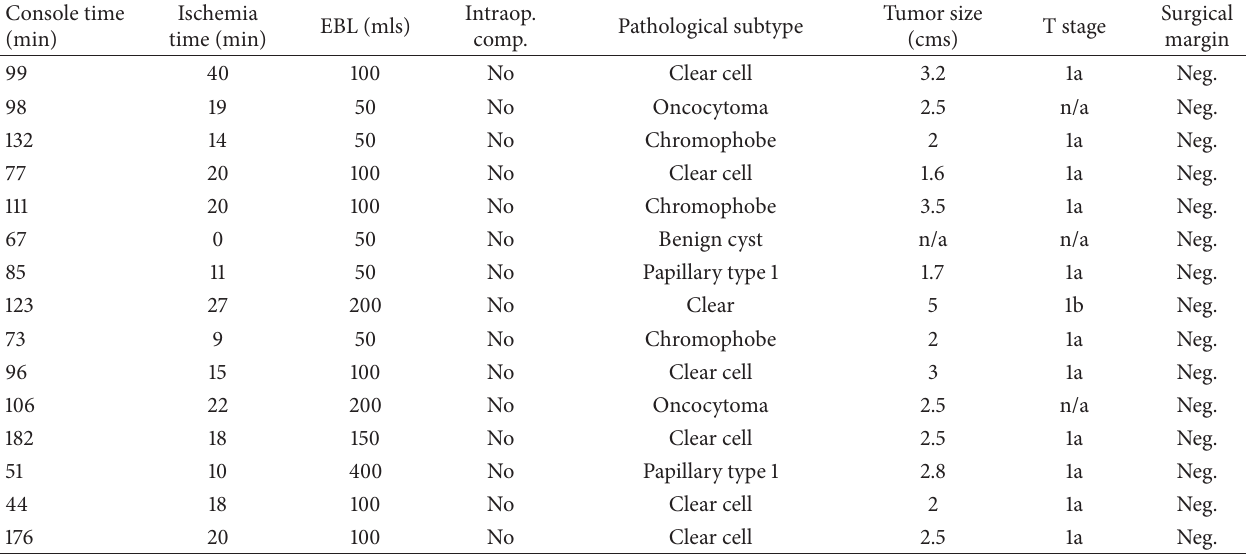
Table 2: Operative and pathologic